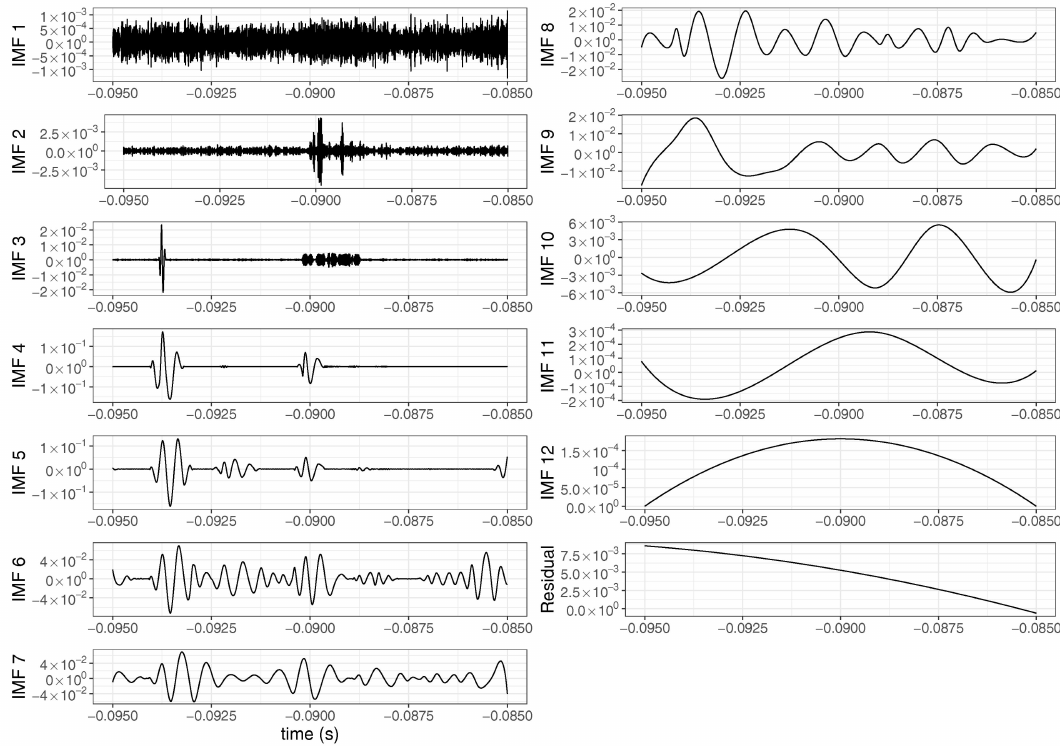
Figure 9. IMFs extracted with the EMD procedure.